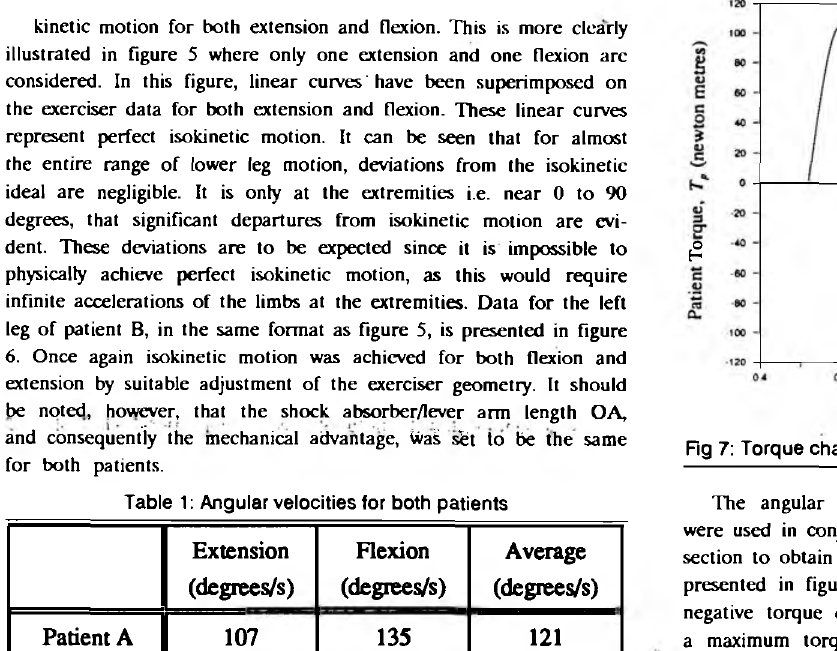
Fig 6: Angular displacement versus time plot for patient B - left leg, one cycle